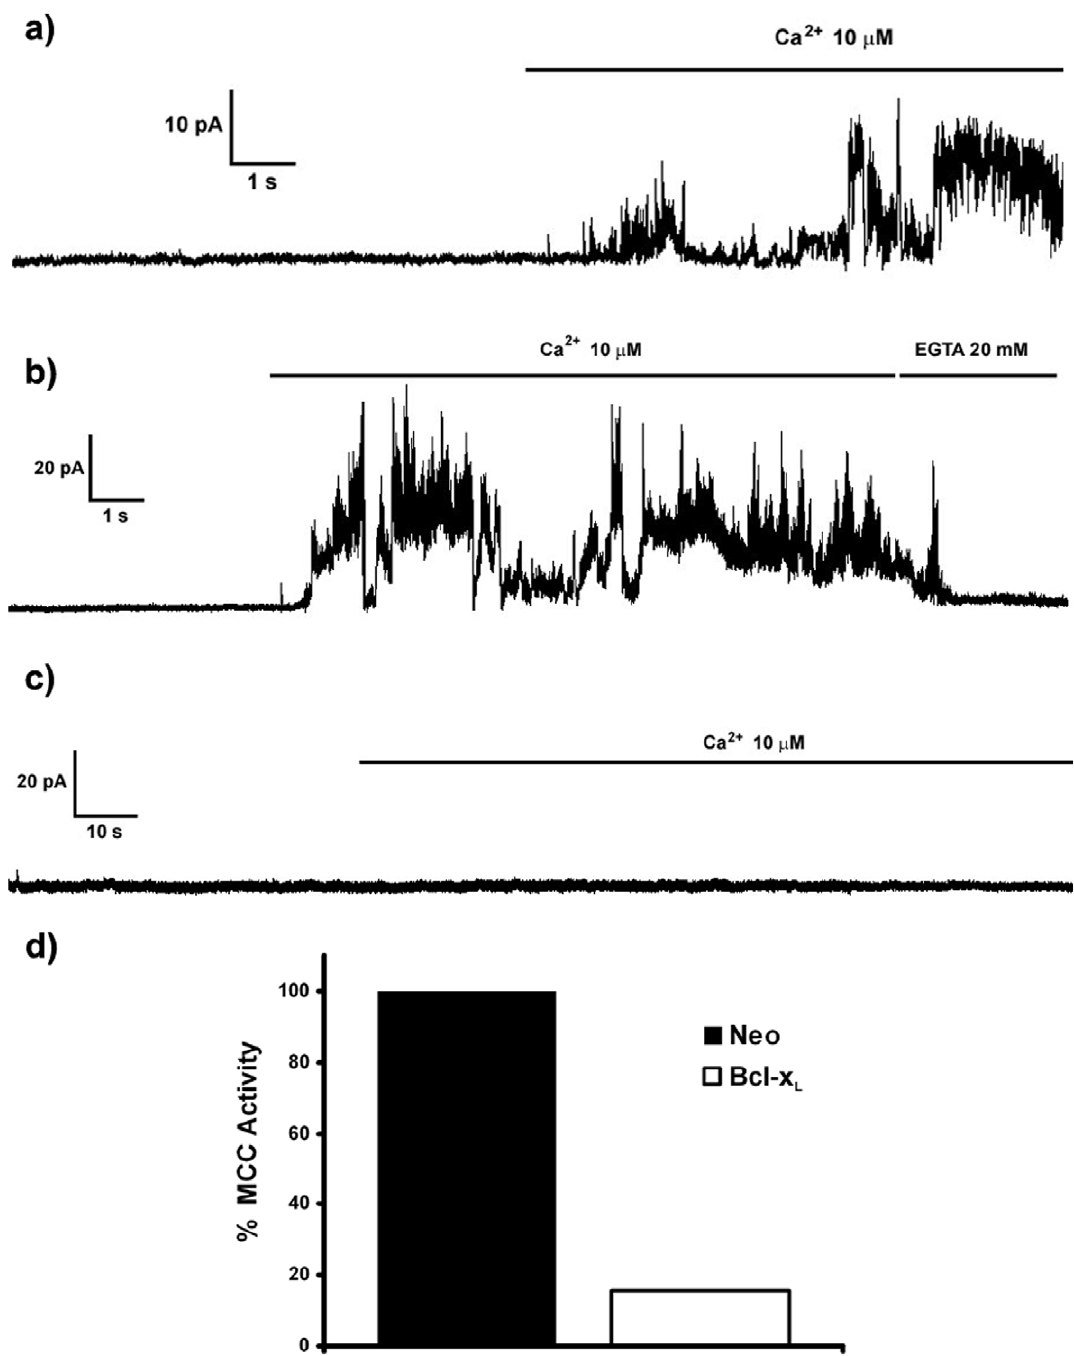
Figure 4. Bcl-x L blocks the Ca 2 + -induced MCC activation in isolated mitoplasts. Mitoplasts were prepared and single channel activity was recorded as indicated in Materials and Methods. a) Induction of MCC activity following increase in Ca 2 + concentration (upper bar) in SH-SY5Y/Neo cells. b) Inhibition of Ca 2 + -induced MCC activation by Ca 2 + chelation in SH-SY5Y/Neo. EGTA 20 mM was added after Ca 2 + stimulation (upper bars). c) Same protocol as in a) performed in mitoplasts obtained from SH-SY5Y/Bcl-x L cells. No channel activity can be observed after 10 m M Ca 2 + addition despite the channel was present in the patch (supplemental material figure S1). d) Percentage of patches where a rise in Ca 2 + (10 m M) induced MCC activity provided that the channel was present in the patch. This was tested at the end of the experiment as indicated in Material and Methods. Data represent the percentage of patches where the channel was opened for SH-SY5Y/Neo (n=10) and SH-SY5Y/Bcl-x L (n=13) cells. doi:10.1371/journal.pone.0020423.g004 Calcium might convert the ANT transporter into a large the mitochondrial MCC and delaying both Ca 2 + -mediated Dy m and MIMP. This leads to a lower caspase 9 and caspase 3 unselective channel, through its binding to cardiolipin [36]. This activation and to a decrease in neuronal death. modulates the activity of MCC that is responsible for the